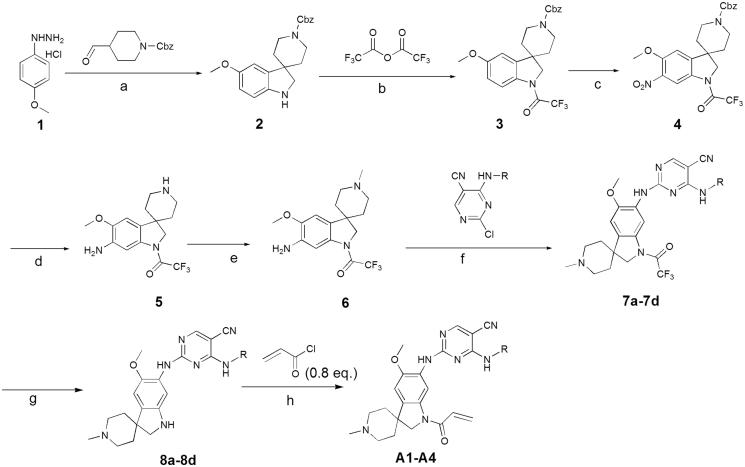
Synthesis of A1-A4, Reagents and conditions: (a) (i) TFA, Toluene, rt, (ii) NaBH4, MeOH, rt; (b) TEA, DCM, 0 °C; (c) Cu(NO3)2.3H2O, Ac2O; (d)Pd/C, H2, rt; (e) MeI, TEA, THF, rt; (f) PTSA, 2- propanol, dioxane, 80 °C; (g) K2CO3, MeOH, rt; (h) TEA, DCM, –20 °C.